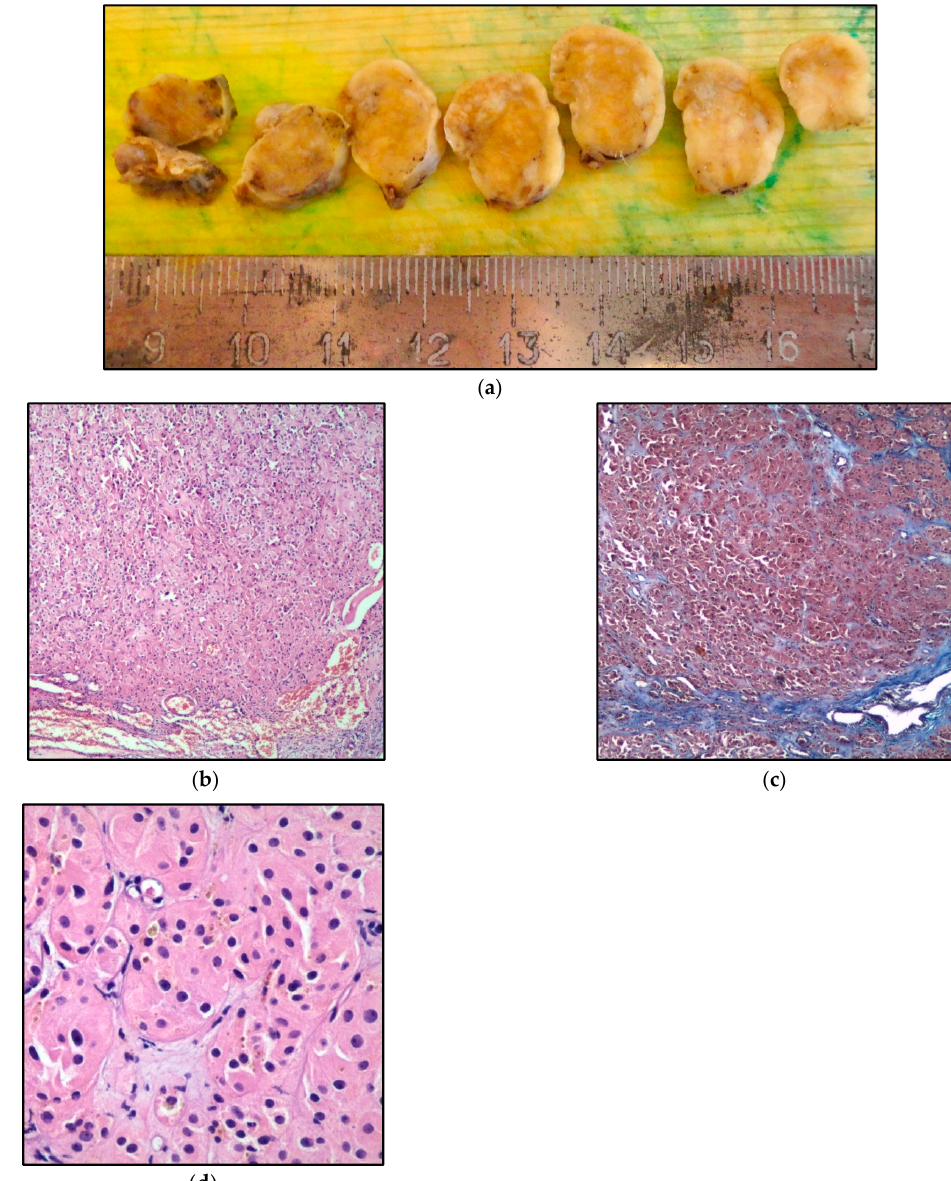
Figure 2. Leydig cell tumors of the right ovary: ( a ) macro preparation ; ( b ) large fields of large round and polygonal cells, H&E, ×40; ( c ) weak fibrous stroma (collagen stromal fibers are col- ored blue), Masson’s trichrome, ×40; ( d ) tumor cells are round and polygonal with abundant fine- grained eosinophilic cytoplasm, H & E,